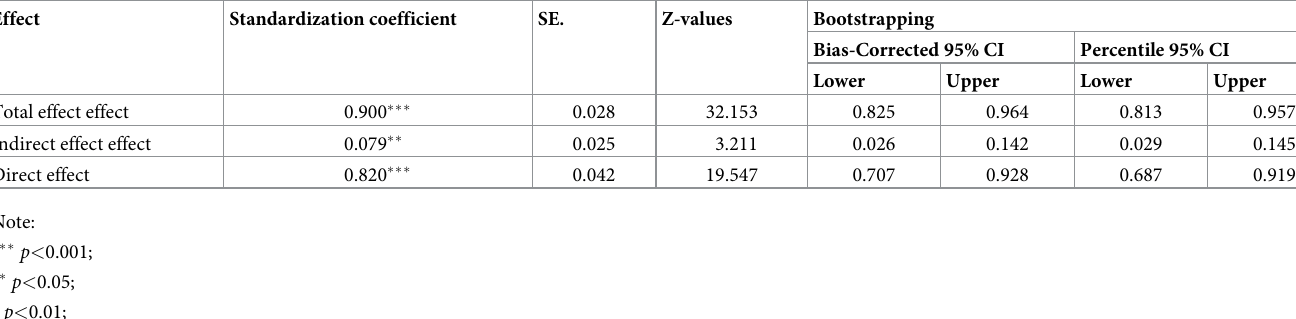
Table 7. Result of the mediating